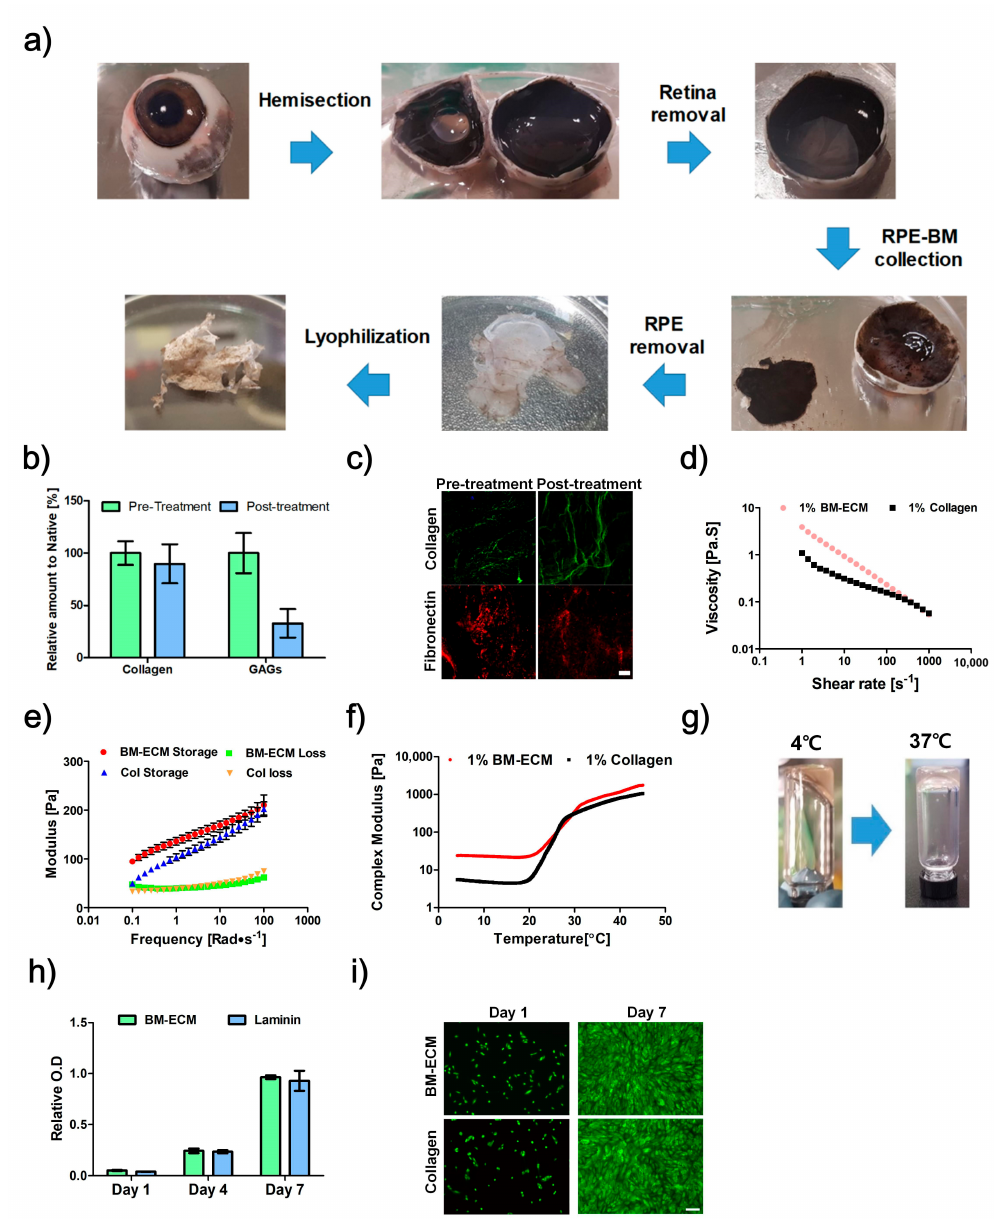
Figure 1. The development process of Bruch’s membrane-derived extracellular matrix bioink (BM-ECM). ( a ) Isolation procedure for BM. ( b ) Biochemical analysis of collagen and glycosaminoglycans (GAGs) for BM pre- and post-treatment with sodium dodecyl sulfate (SDS). ( c ) Immunofluorescence images of collagen type-1 and fibronectin for BM pre- and post-treatment with SDS. Rheological analysis results, ( d ) Viscosity, ( e ) storage modulus and loss modulus, and ( f ) complex modulus of BM-ECM and collagen in different conditions. ( g ) Sol-gel transition of 1% BM-ECM as a result of an increase in temperature. ( h ) Proliferation of ARPE-19 on non-coated, collagen, and BM-ECM-coated surfaces. ( i ) Live/Dead assay of ARPE-19 on non-coated, collagen, and BM-ECM-coated surfaces (Green: Live, Red: Dead). Scale bar: ( c ) 50 µ m, ( i ) 200 µ m. The error bars represent the standard